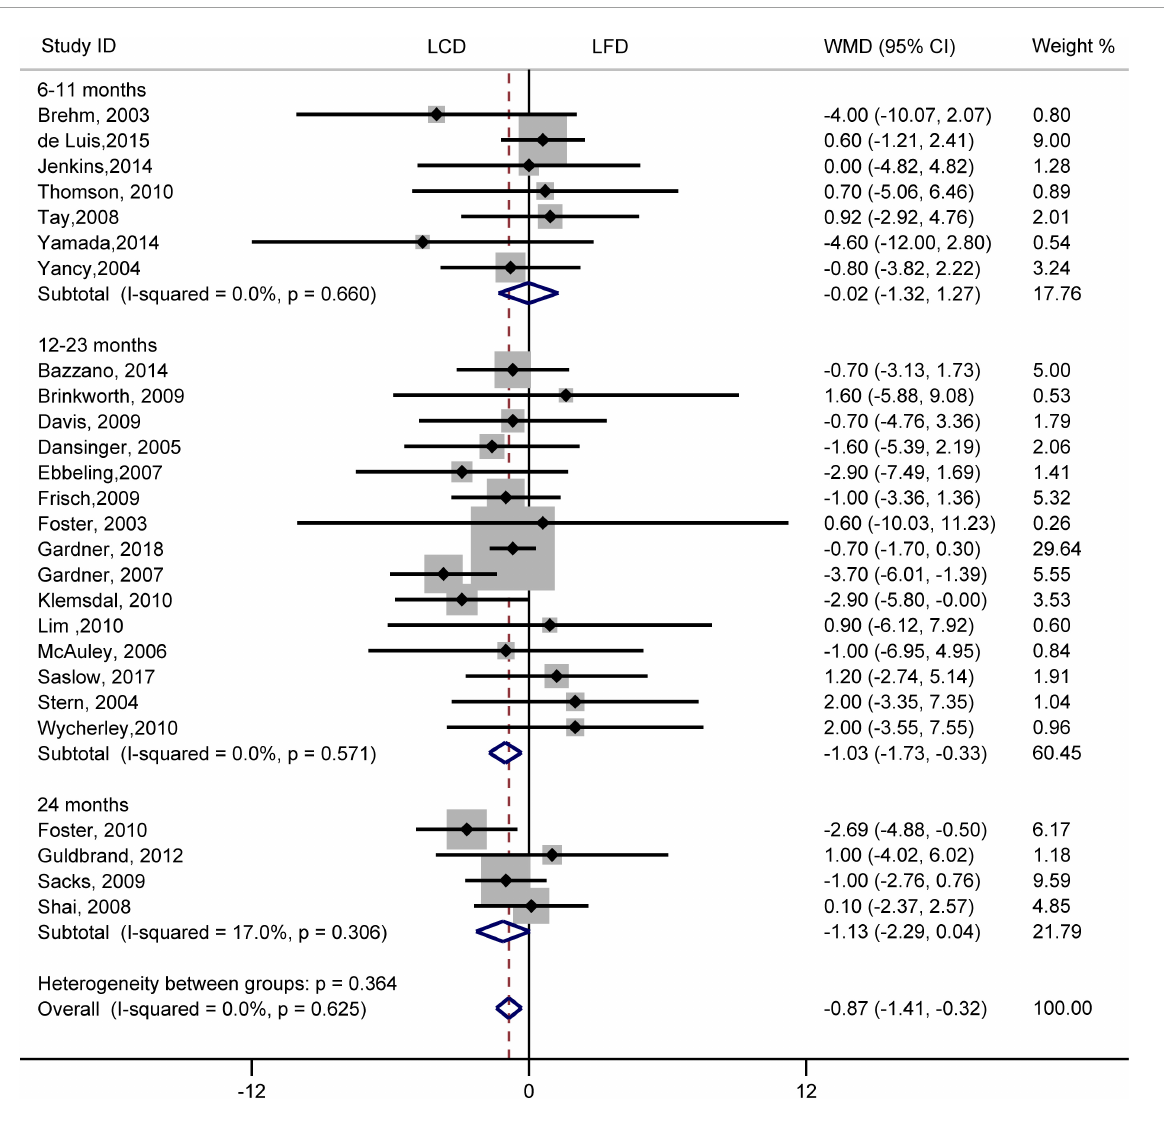
FIGURE6 Forest plots showing weight mean differences (WMD) and 95% CI for diastolic blood pressure of the low-carbohydrate diets (LCD) in comparison with low-fat diets